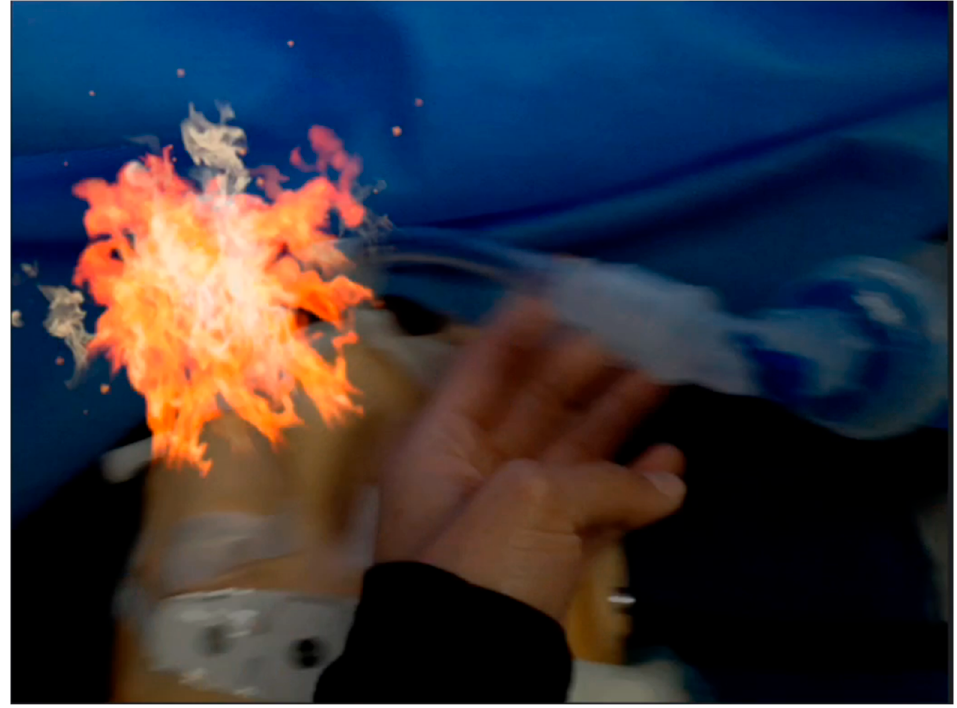
Figure 4. Student view of fire near the patient airway. Source: University of Miami IT Department.